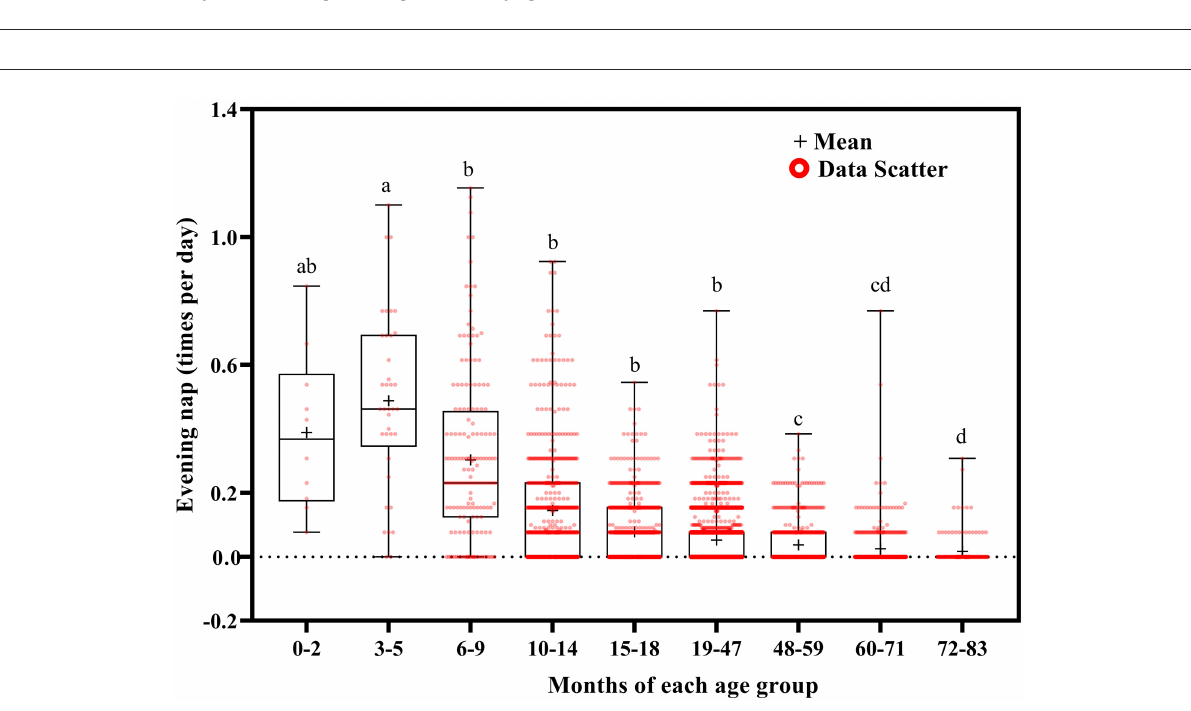
FIGURE9 Results of the one-way ANOVA for evening nap stratified by age.